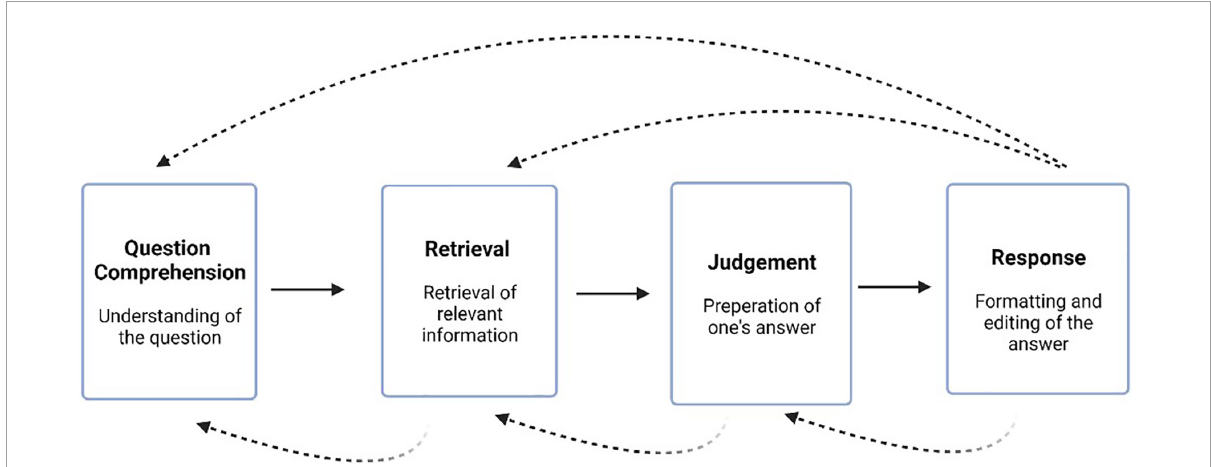
FIGURE2 Cognitive processing steps: comprehension, retrieval, judgment, and response. Solid arrows show a linear forward direction between processes. Dotted arrows show potential recursive processes between steps (15).